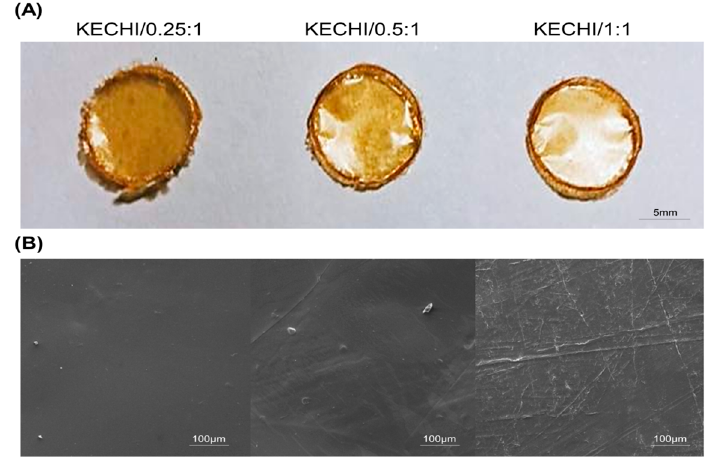
Figure 1. ( A ) Appearance of Keratin-chitosan membranes; ( B ) SEM images of membrane (KECHI/0.25:1, KECHI/0.5:1, and